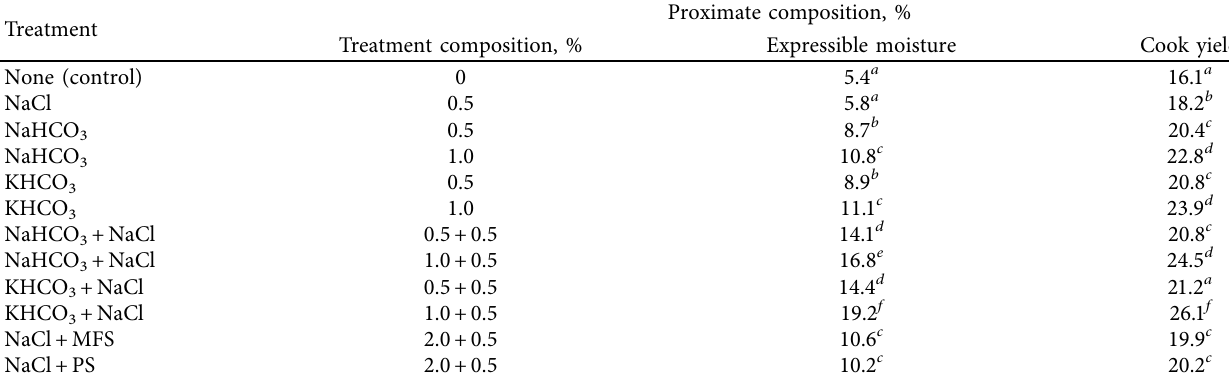
Table 3: Least-squares means for the proximate composition of cooked meatloaf treated with different levels of sodium bicarbonate, potassium bicarbonate, salt, modified food starch, and potato.